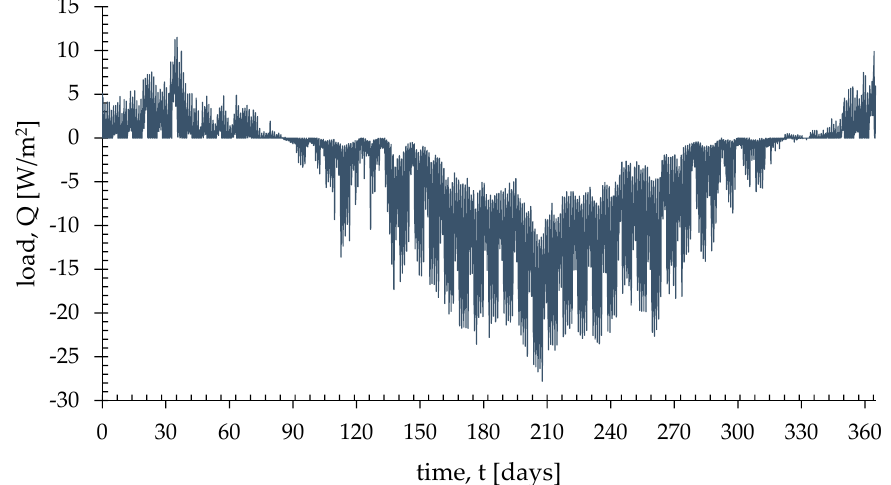
Figure 3. Heating and cooling loads of a typical residential building with nZEB technical characteristics in Lefkosia, Cyprus, per square meter.